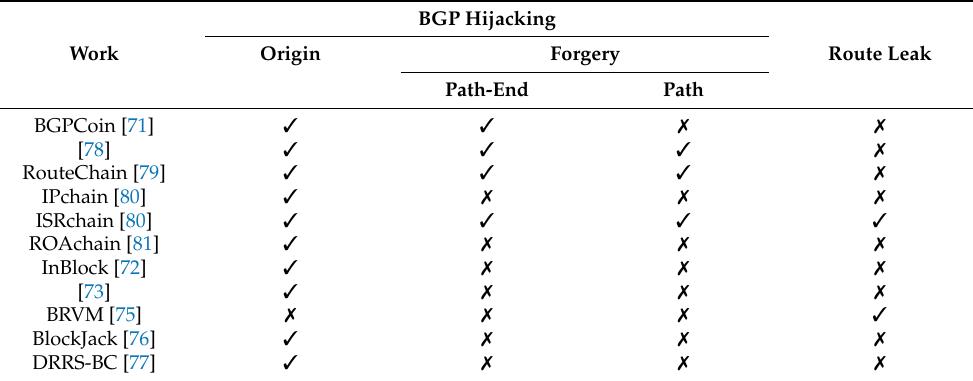
Table 6. Summary of attacks